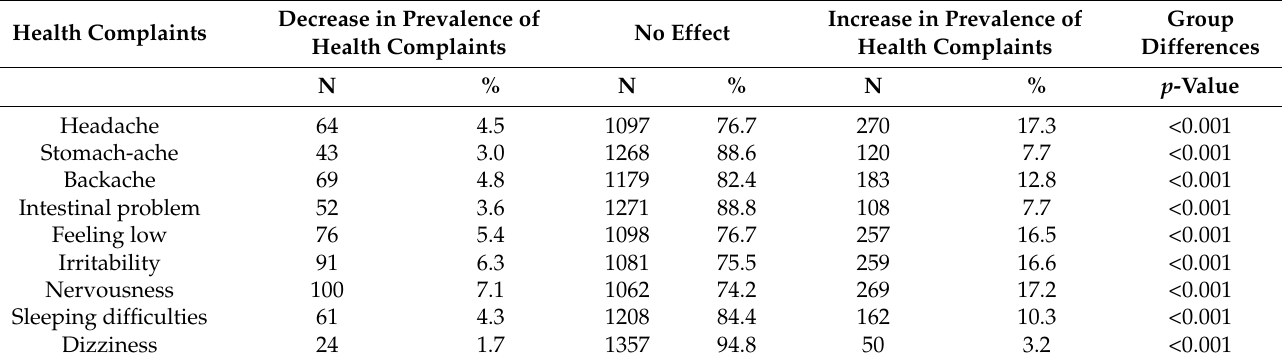
Table 2. The coronavirus pandemic and the incidence of health